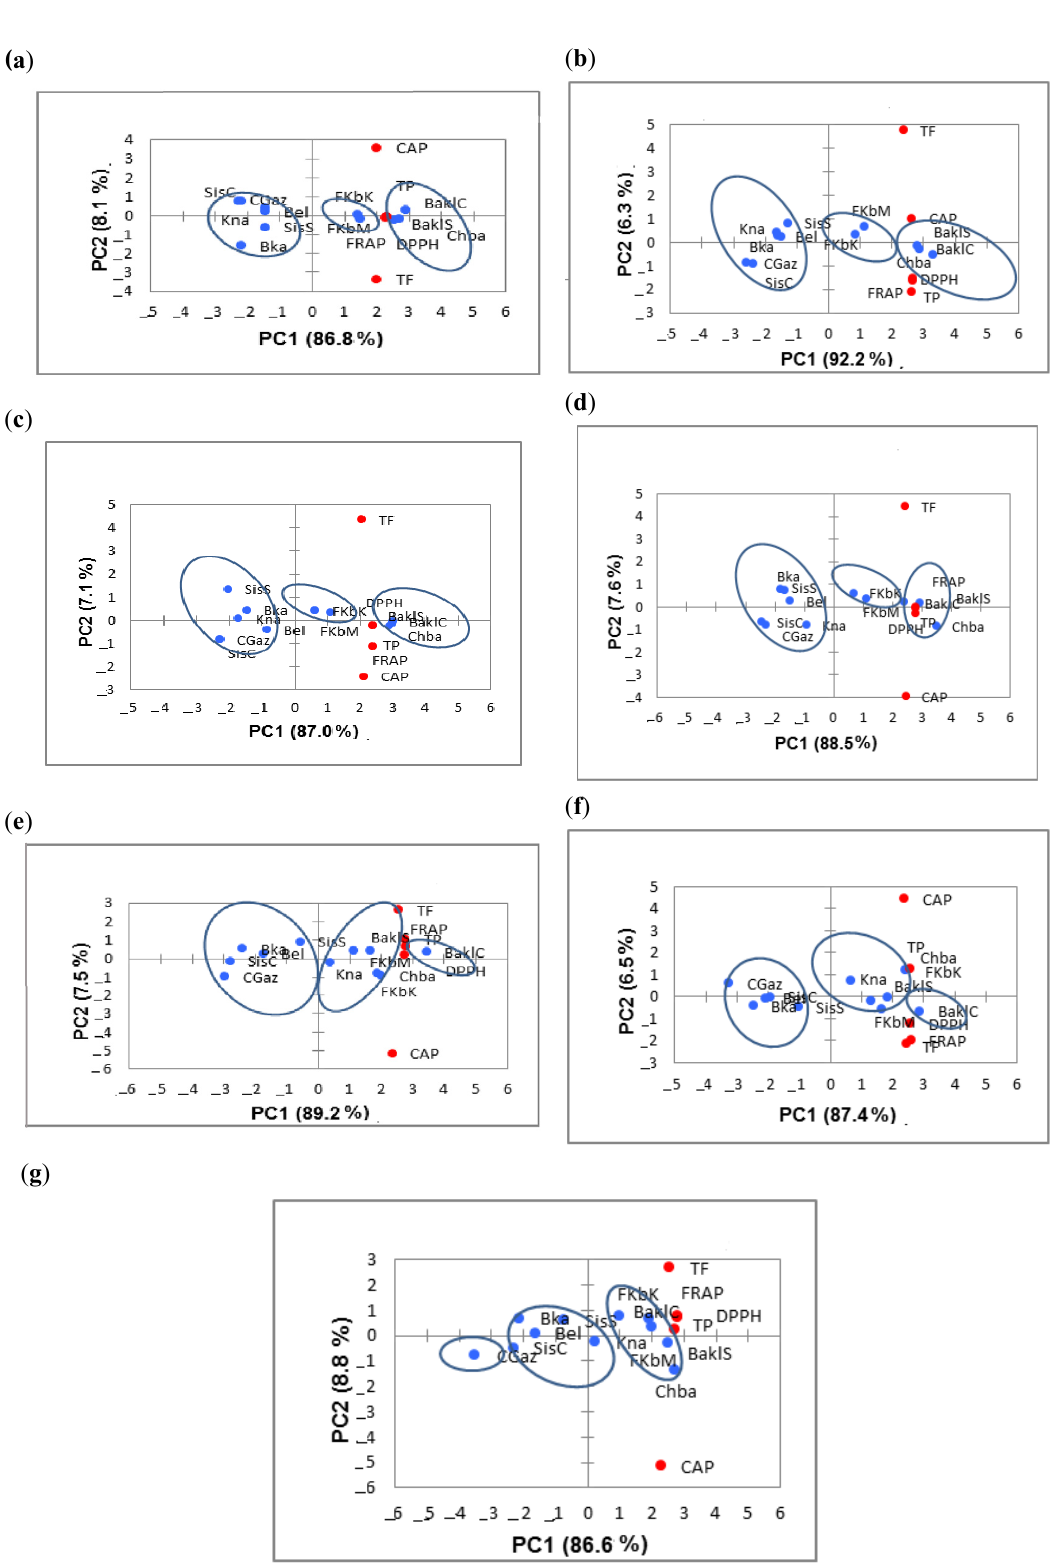
Figure 4. Principal component analysis based on phytochemical compounds and antioxidant activity (by DPPH and FRAP assays) analyzed at 10 ( a ), 25 ( b ), 40 ( c ), 55 ( d ), 70 ( e ), 85 ( f ) and 100 DAA (days after anthesis) ( g ) in the eleven Tunisian chili pepper accessions. TP: total phenol content. TF: total flavonoid content. CAP: capsaicin content. See caption to Figure 2 for the list of acronyms used for the studied accessions.